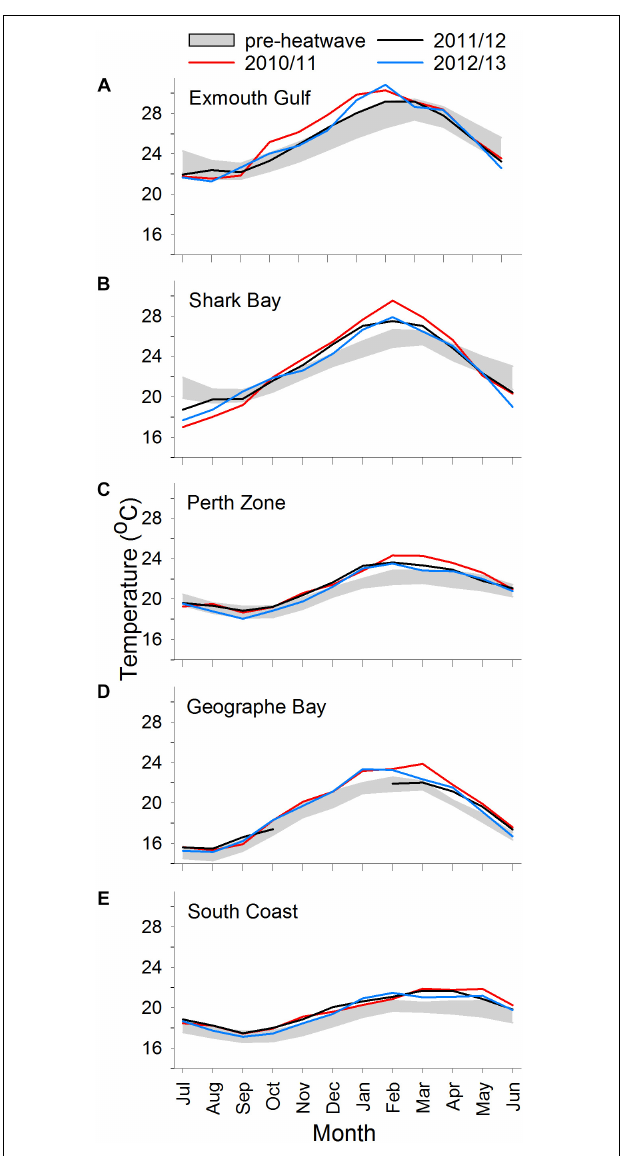
FIGURE 2 | Mean monthly ocean temperatures in individual years 2010/2011, 2011/2012, and 2012/2013 vs. pre-heatwave years (years pooled; shaded area is mean ± SD) at (A) Exmouth, (B) Shark Bay, (C) Perth Zone, (D) Geographe Bay, and (E) South Coast. Pre-heatwave years